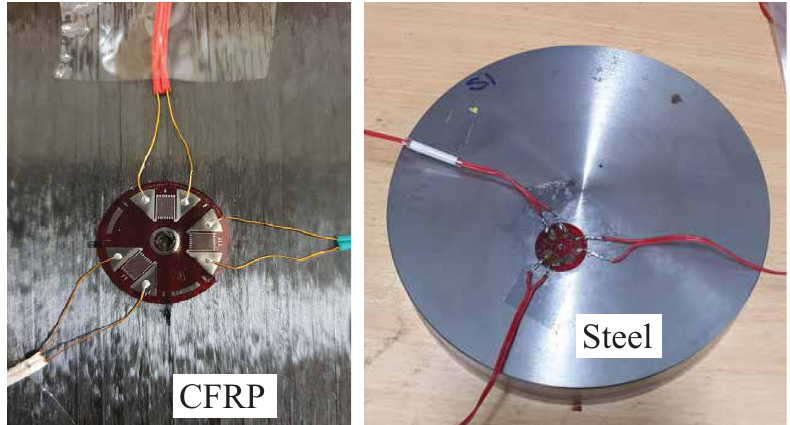
Figure 9. Measuring strains in composite and metal